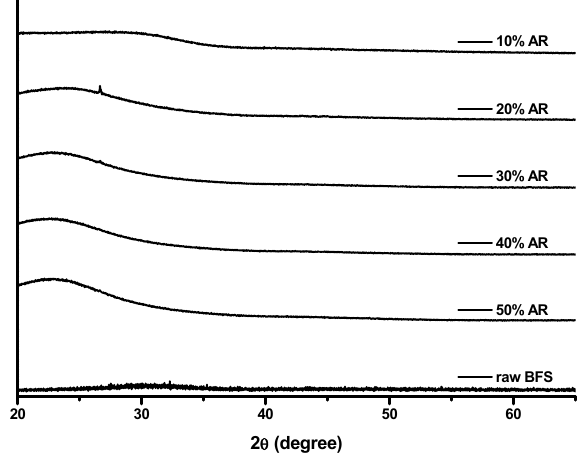
Figure 5. XRD patterns of the separated solid phase treated by AR-DI water and raw BFS. Table 4. Oxide compounds found in BFS treated by AR-DI water as well as their specific surface areas. AR